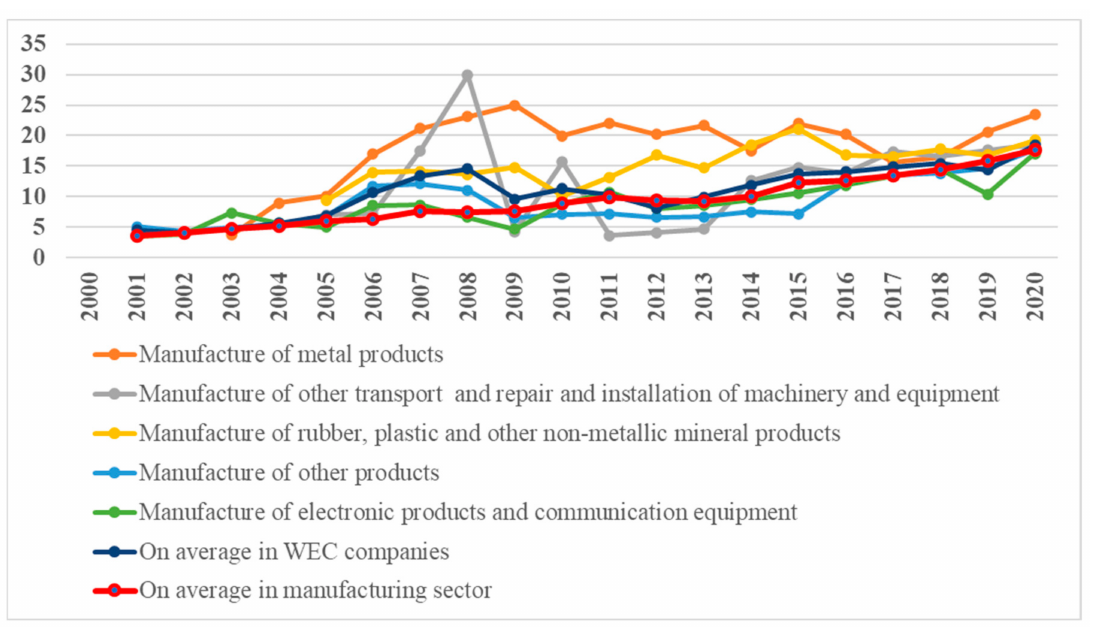
Figure 4. Number of employees, in persons and %.